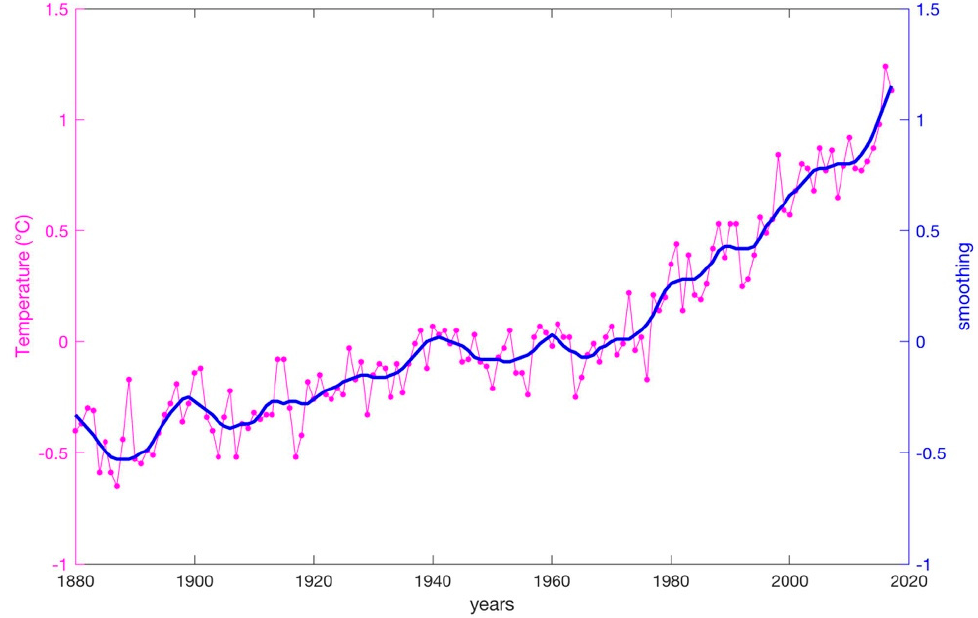
Figure 9. Global surface temperature trend from 1880 to 2017 (Data: NASA Goddard Institute for Space Studies. Dataset accessed 14 June 2018 at https://data.giss.nasa.gov/gistemp/).